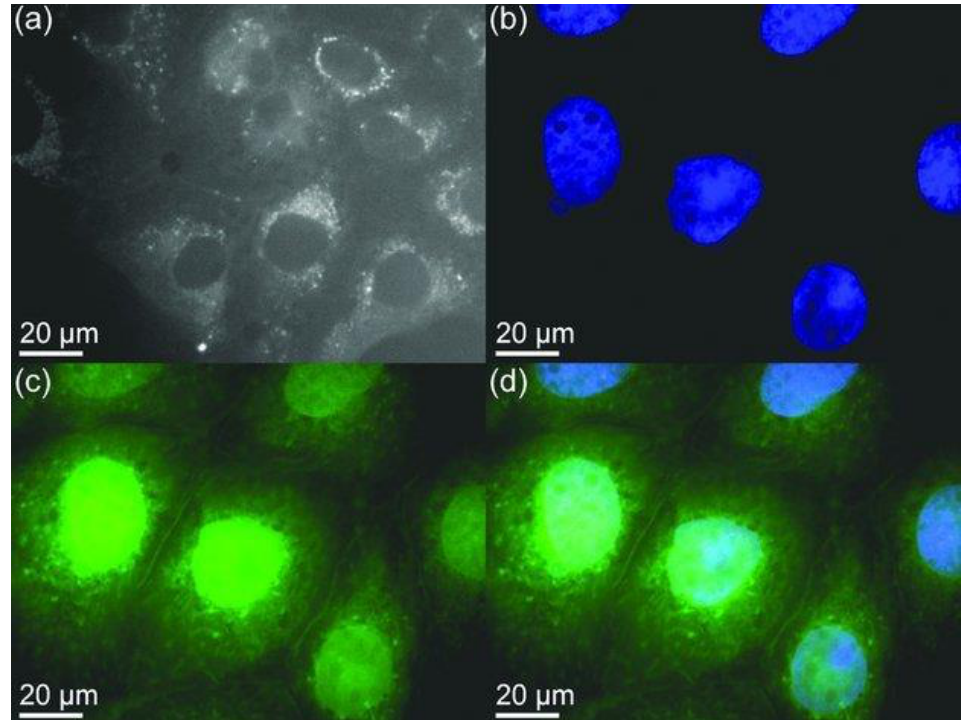
Figure 8. Confocal microscopy images of mammalian cells. ( a ) Agglomerated BNQDs surrounding each nucleus (cells are stained by BNQDs only). ( b ) Individual nucleus stained blue with DAPI (4’, 6-diamidino-2-phenylindole). ( c ) BNQDs with green luminescence surrounding the nuclei. ( d ) The overlay image of cells stained with DAPI and BNQDs. Reproduced from [23] with permission from 2013 Wiley-VCH Verlag GmbH & Co. KGaA (Weinheim, Germany).